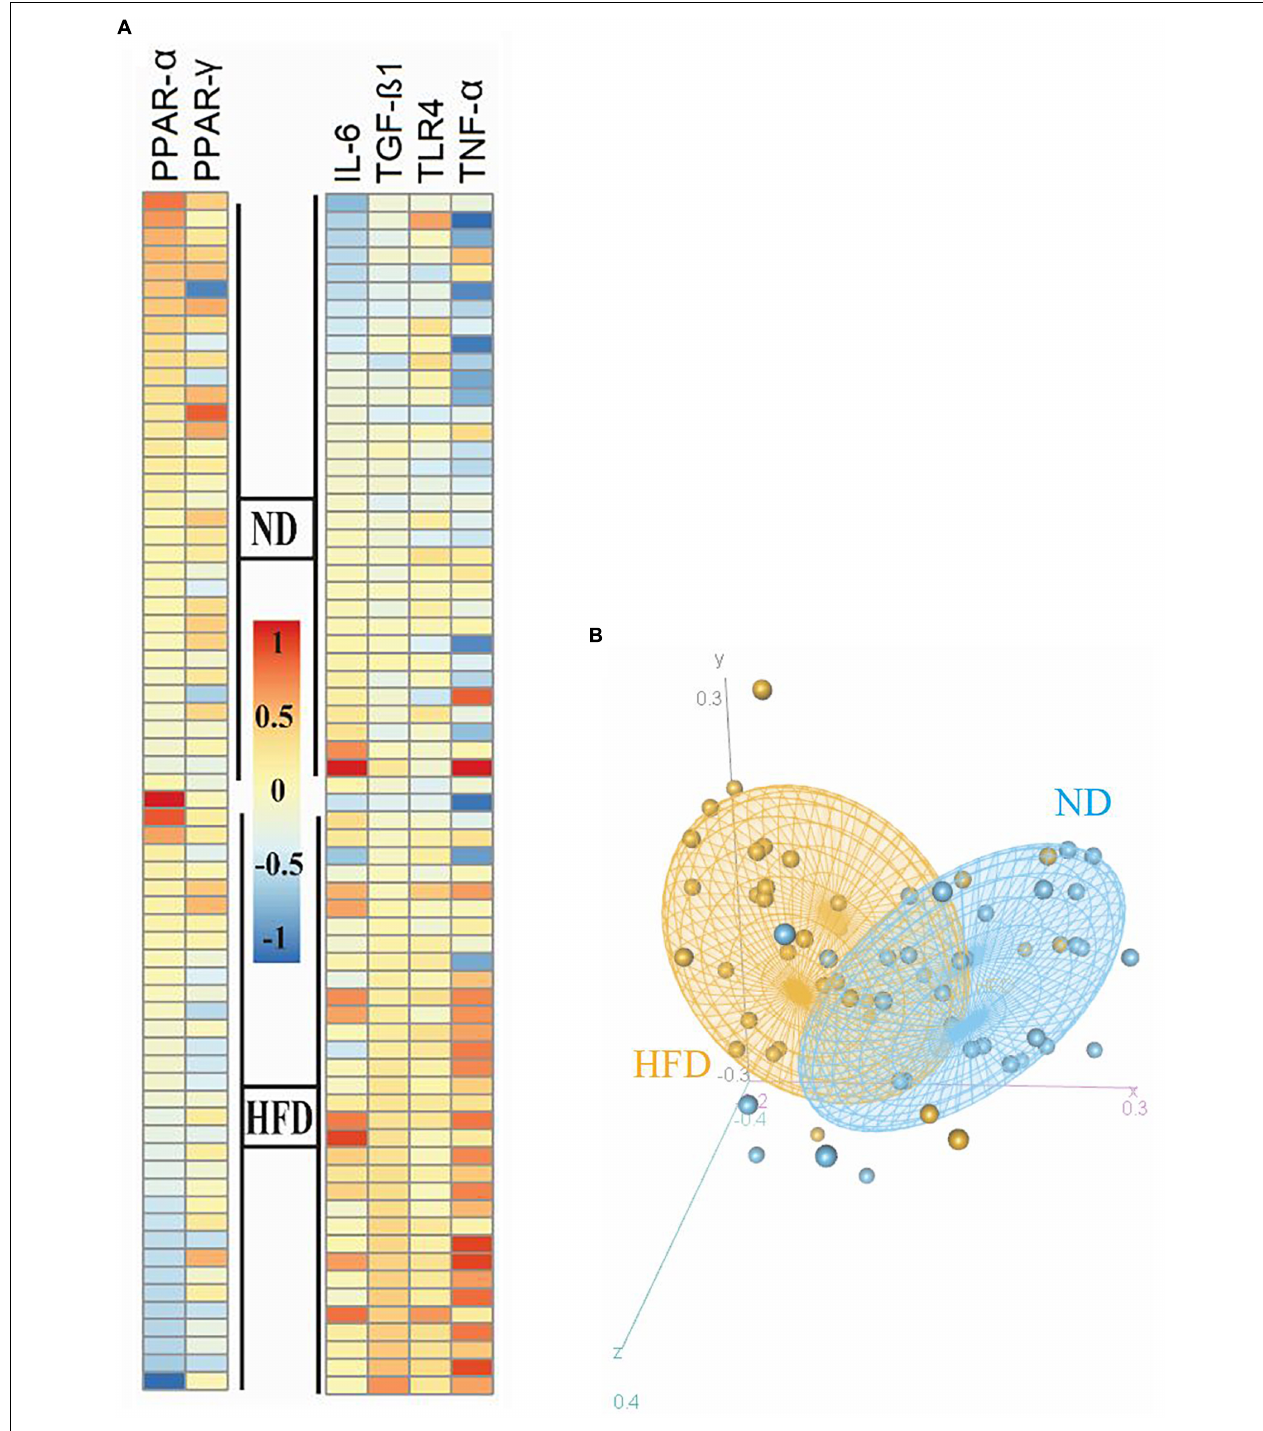
FIGURE 2 | Heatmap and PCA correlation show different genes involved in inflammation and FA oxidation in the epididymal adipose tissue between HFD and ND mice. (A) Heatmap plot revealed inflammatory genes ( TNF- α , IL-6 , and TLR-4 ) and TGF- β were expressed at significantly higher levels in the obese than in the normal group. (B) Regulator genes involved in FA oxidation and inflammation ( PPAR- γ and PPAR- α ) were downregulated in HFD- compared to ND-fed mice. PCA plot showed that the ND group was clustered relatively from the HFD group. The HFD and ND groups are indicated by orange and blue colors, respectively.